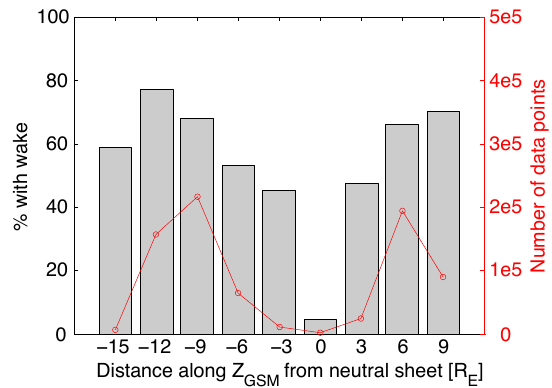
Fig. 5. Detection probability as a function of the distance from the neutral sheet. Percentage of all events where cold ions have been detected as a function of distance along Z GSM . The red points show the total number of data points in the respective region. (The total data set consists of 765000